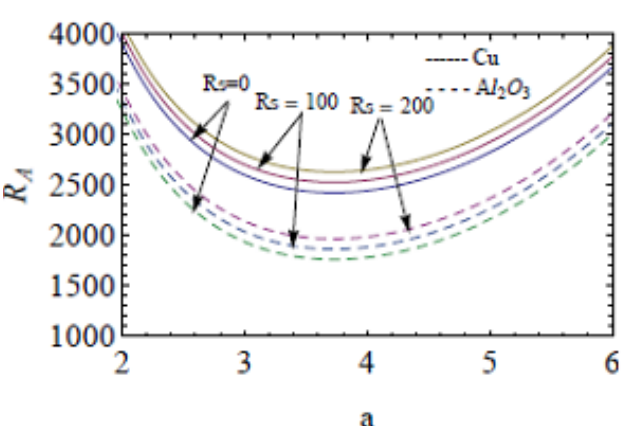
Figure 5. Impact of solute Rayleigh